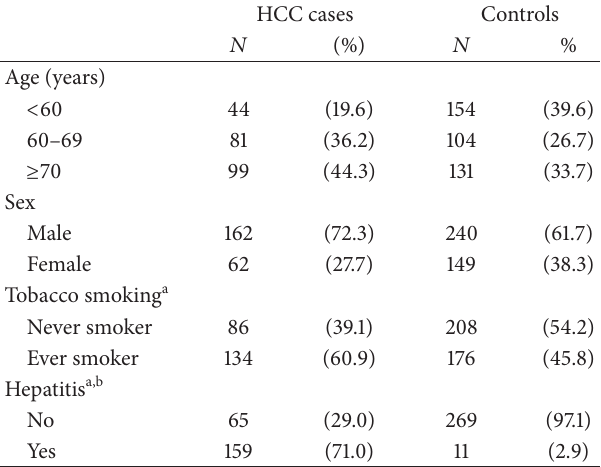
Table 1: Distribution of 224 cases of hepatocellular carcinoma (HCC) and 389 controls according to selected factors (Italy, 2005–